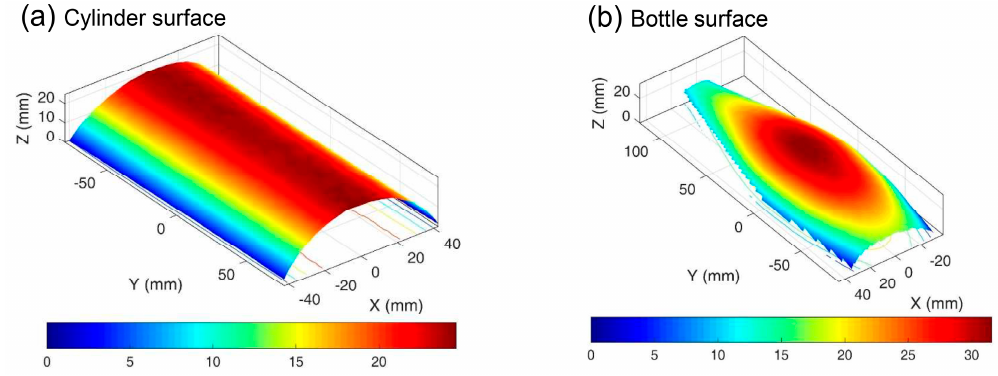
Figure 4. The reconstructed 3D shapes of ( a ) the cylinder and ( b ) the bottle surfaces.